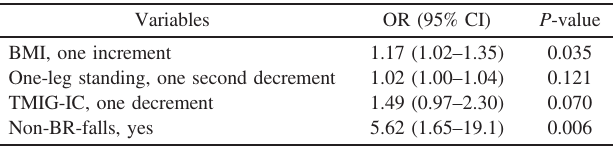
Table 4. Logistic regression analysis of factors associated with a future incident of bicycle-related falls (BR-falls) Variables OR (95% CI) P